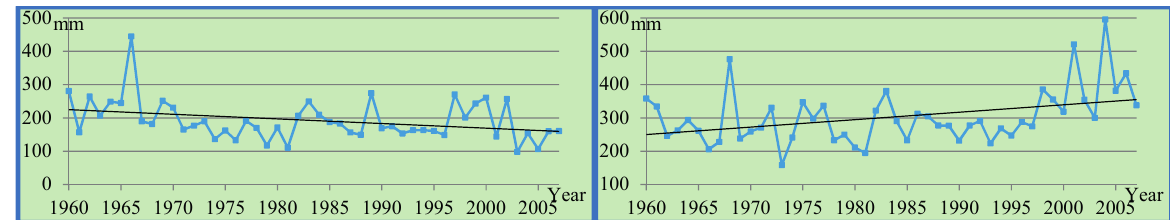
Figure 10. The most significant negative trend with a slope of − 0.6701 ( left ) and the most significant positive trend with a slope of 0.1116 ( right ) of the RX1day index.